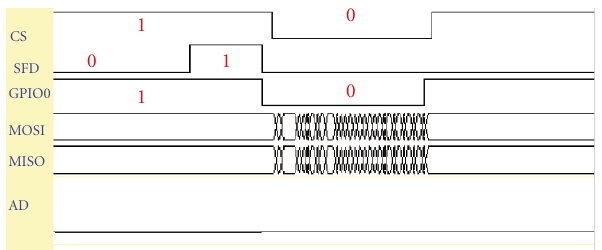
Figure 20: Process of packet